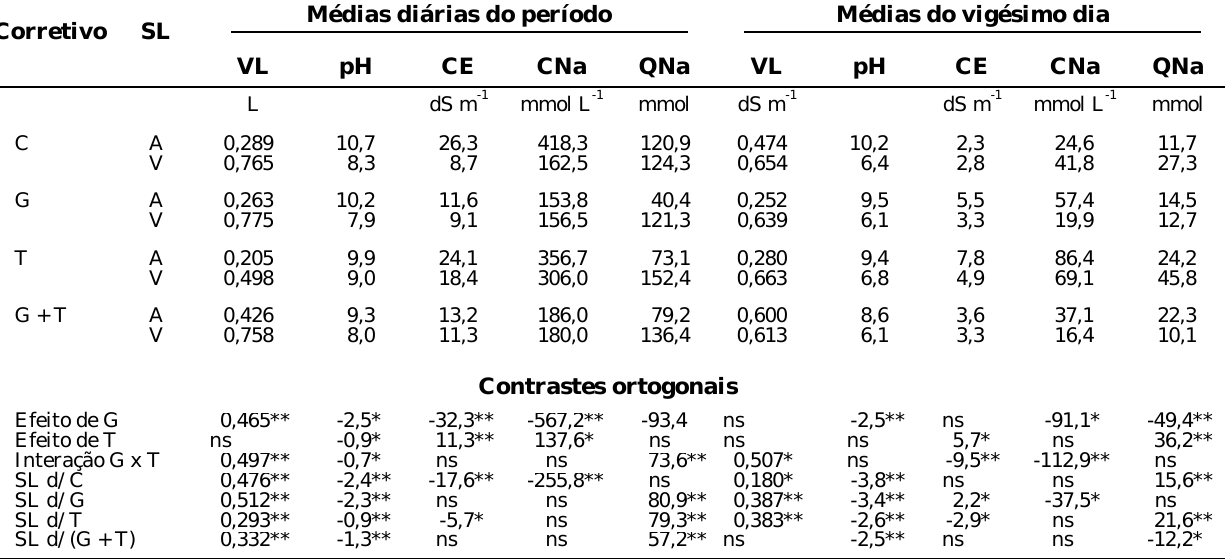
Quadro 1. Volume lixiviado (VL), pH, condutividade elétrica (CE), concentração (CNa) e quantidade (QNa) de sódio, considerando o corretivo e a solução de lixiviação (SL). Médias diárias para a totalidade do período e para o vigésimo dia de lixiviação (1)